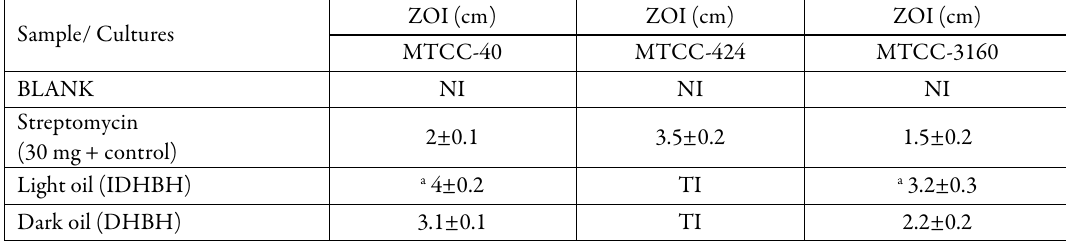
Values are mean of triplicate determination (n = 3) ± standard deviation. ZOI: zone of inhibition, NI: no inhibition; TI: total Inhibition, a: indicates significant difference of light oil at P≤0.05 vs. dark